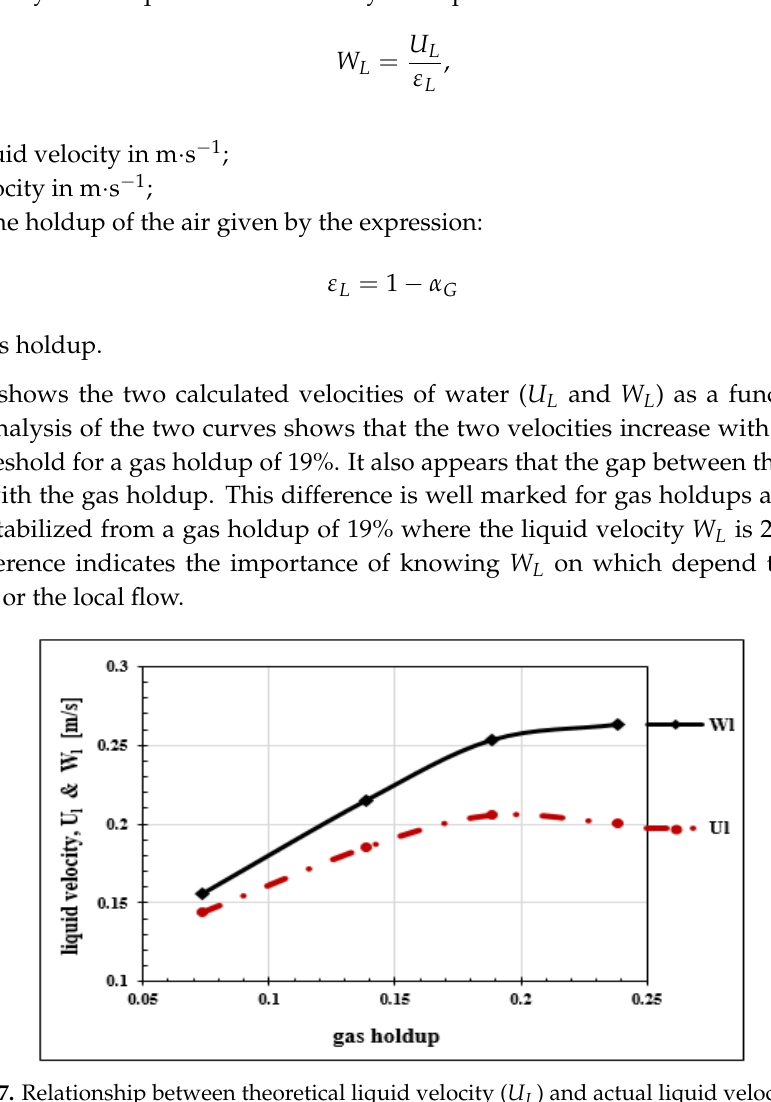
Figure 7. Relationship between theoretical liquid velocity ( U L ) and actual liquid velocity ( W L